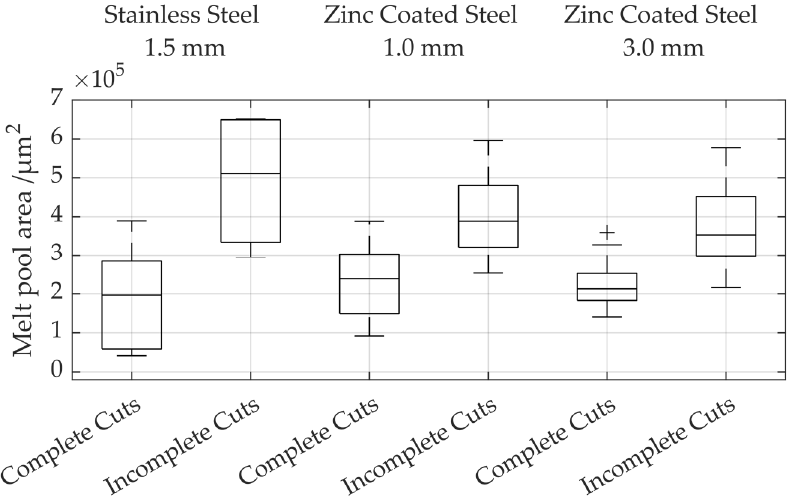
Figure 9. Comparison of the distribution of the melt pool area for complete and incomplete cuts in stainless steel and zinc-coated steel.